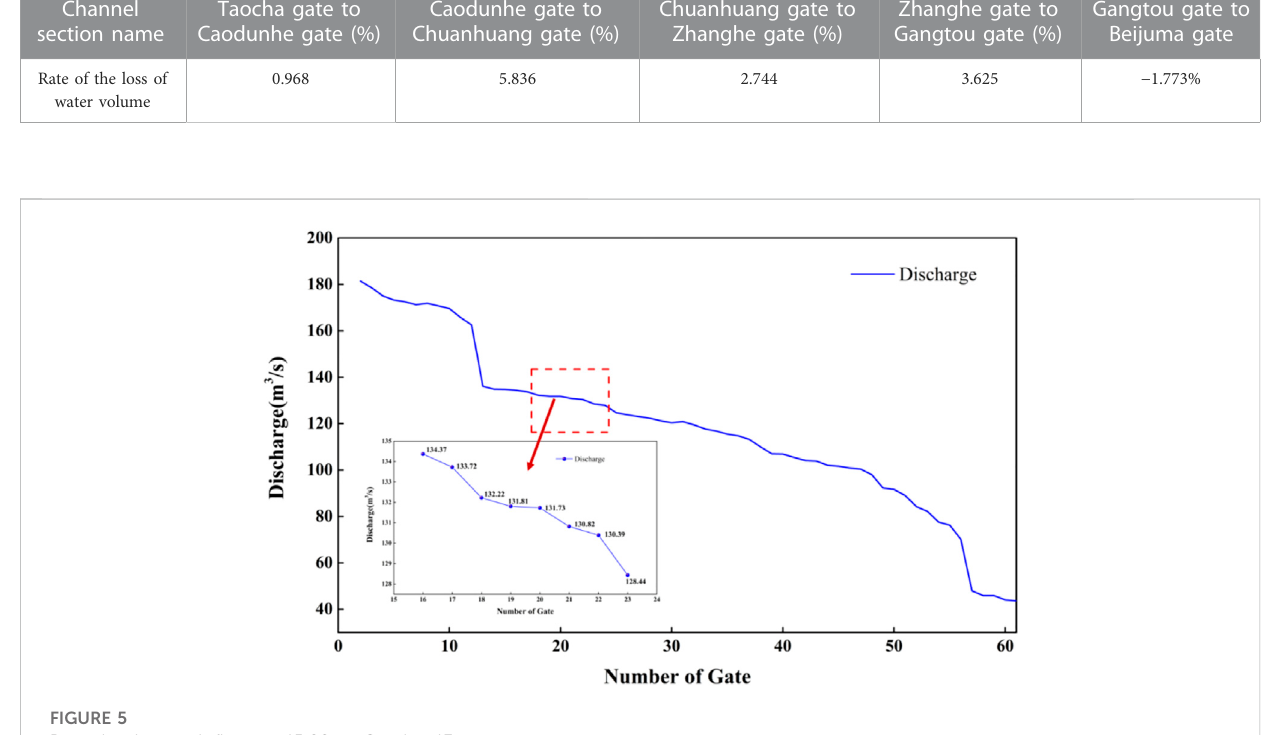
FIGURE 5 Data cleaning result fi gure at 15:00 on October